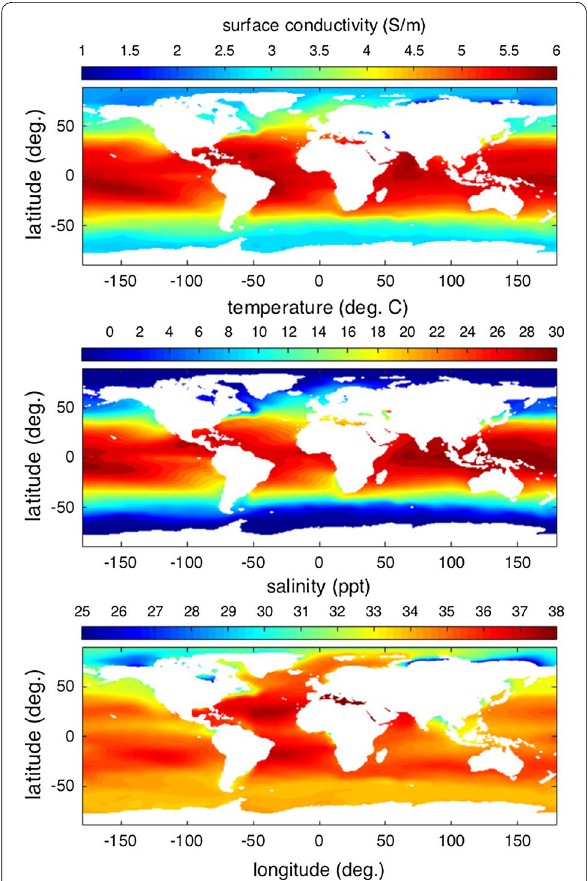
Fig. 1 Electrical conductivity, temperature, salinity, and density at the surface of the global ocean. The full ranges in the surface data are, respectively, 0.0999–6.45 (S/m), 1.84–30.6 (C), 5.02–40.1 −